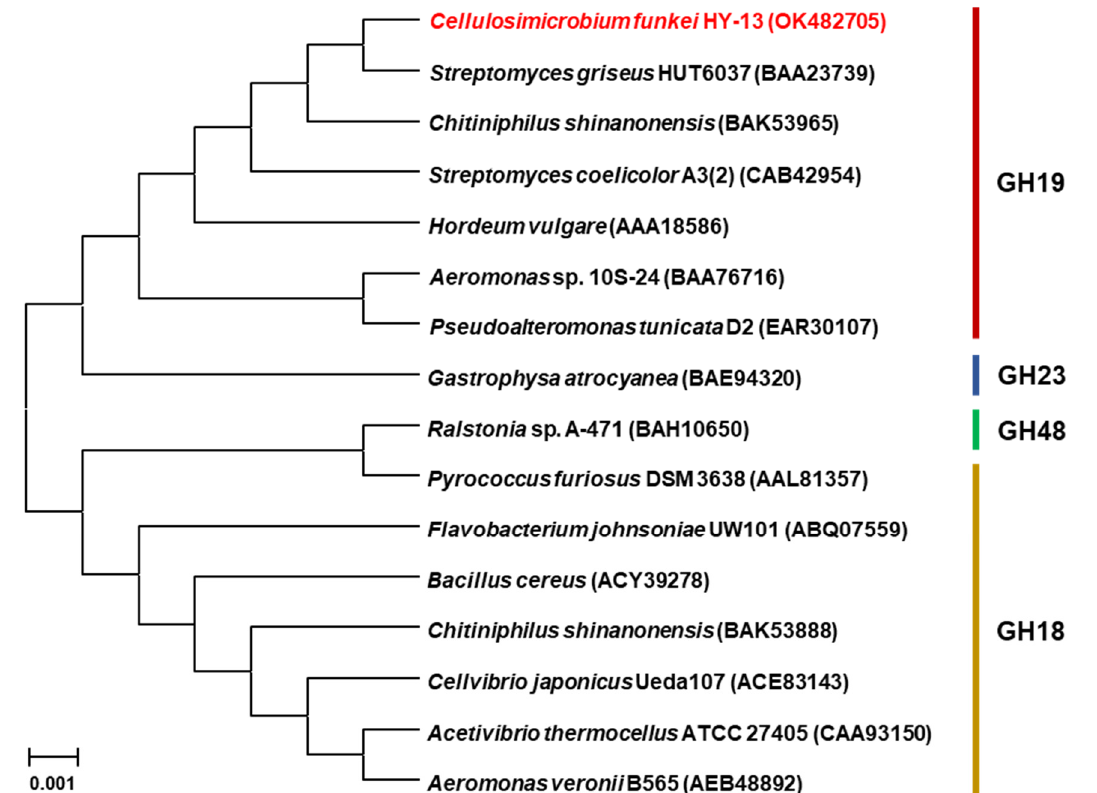
Figure 2. Phylogenetic analysis of C. funkei HY-13 GH19 chitinase (ChiJ) and its closely related functional homologs. Multiple alignment of the amino acid sequences was achieved using ClustalW in the MegAlign software (http://www. megasoftware.net, accessed on 12 May 2021). The protein sequence data used for phylogenetic analysis were retrieved from the GenBank database.